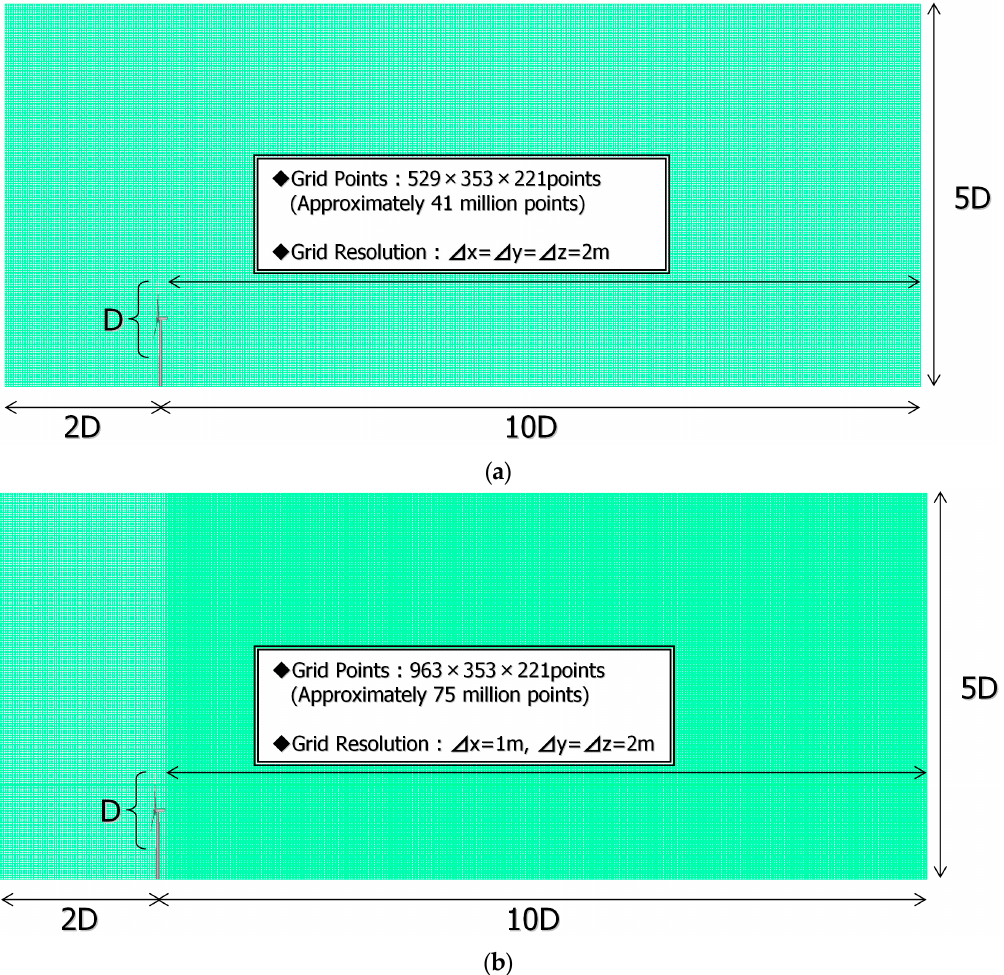
Figure 22. Influence of grid resolution on the CFD PD wake model. ( a ) Standard grid; ( b ) fine grid. Energies 2019 , 12 , x FOR PEER REVIEW